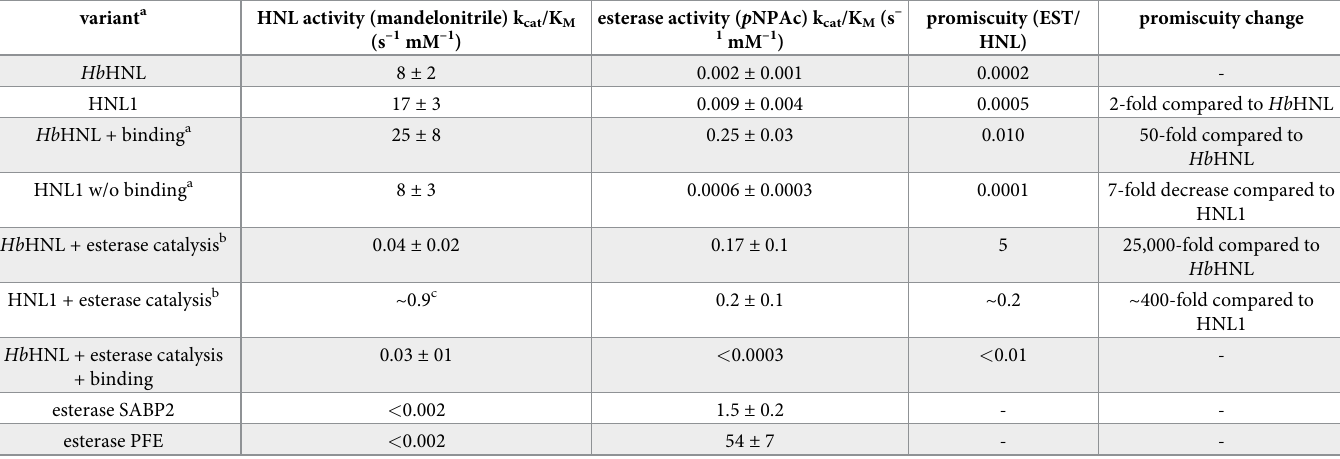
Table 1. Catalytic promiscuity of hydroxynitrile lyases and variants. variant a